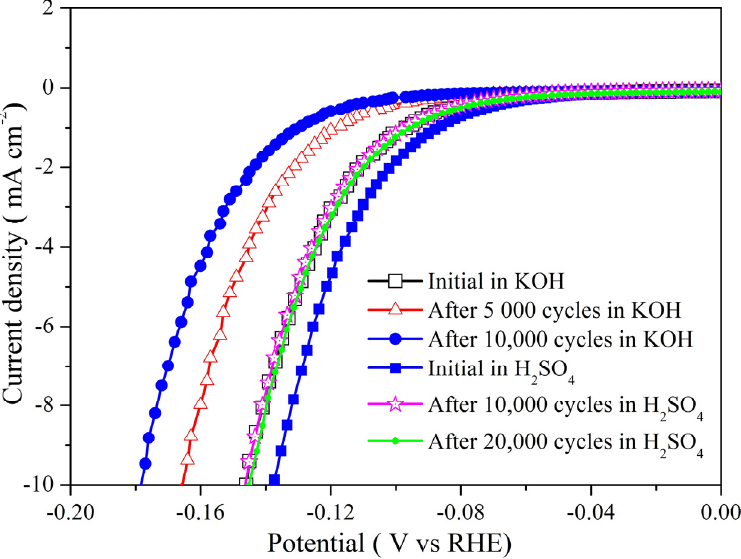
Figure 5. The catalytic stability test of the 250-800-2h catalyst in 0.5 M H 2 SO 4 and 1 M KOH solution.